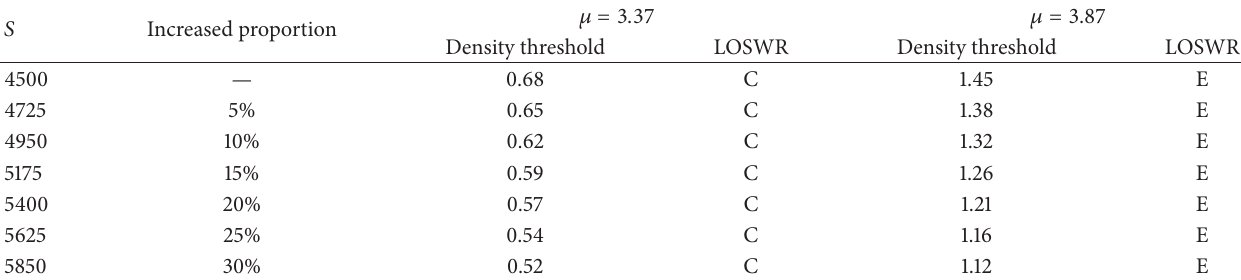
Table 10: The LOSWR varies over the value of 𝑆 ( 𝜇